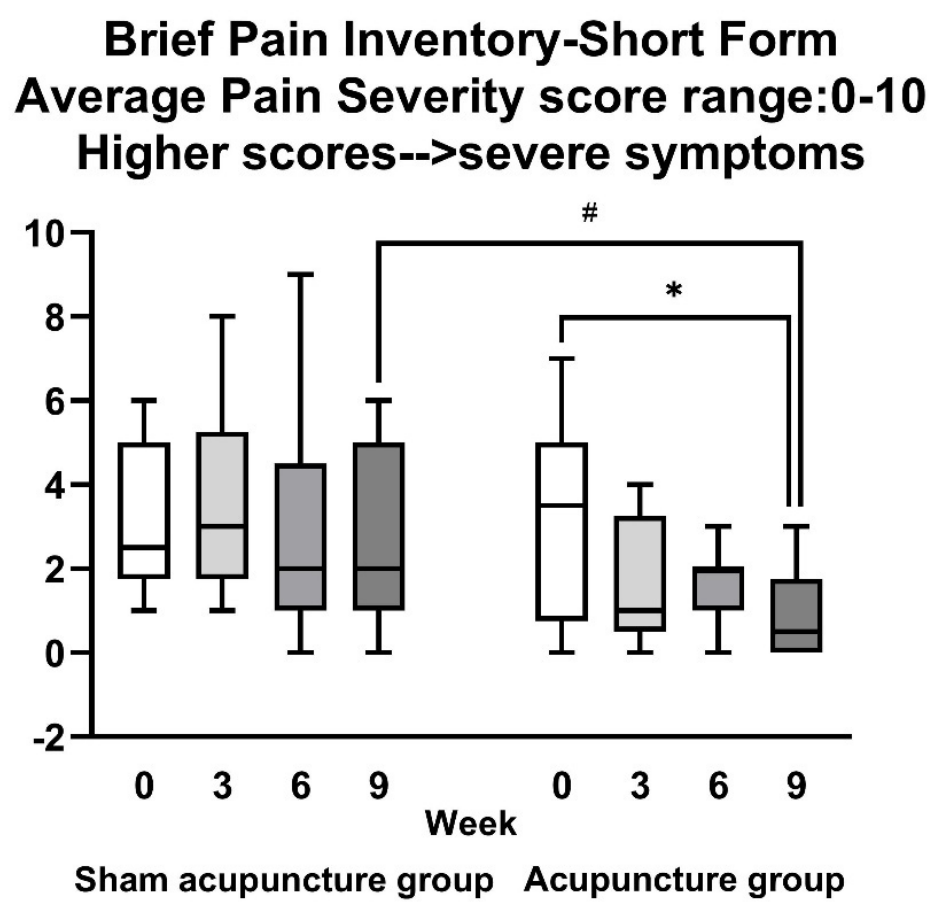
Figure 2. Average pain severity scores in BPI-SF during the treatment periods. Data are expressed as mean ± standard error of the mean (SEM). * p < 0.05 represents the within-group values analyzed using the Wilcoxon signed-rank test. # p < 0.05 represents the between-groups values at the 9th week analyzed using the Mann–Whitney U test. Abbreviations: BPI-SF, Brief Pain Inventory-Short Form.